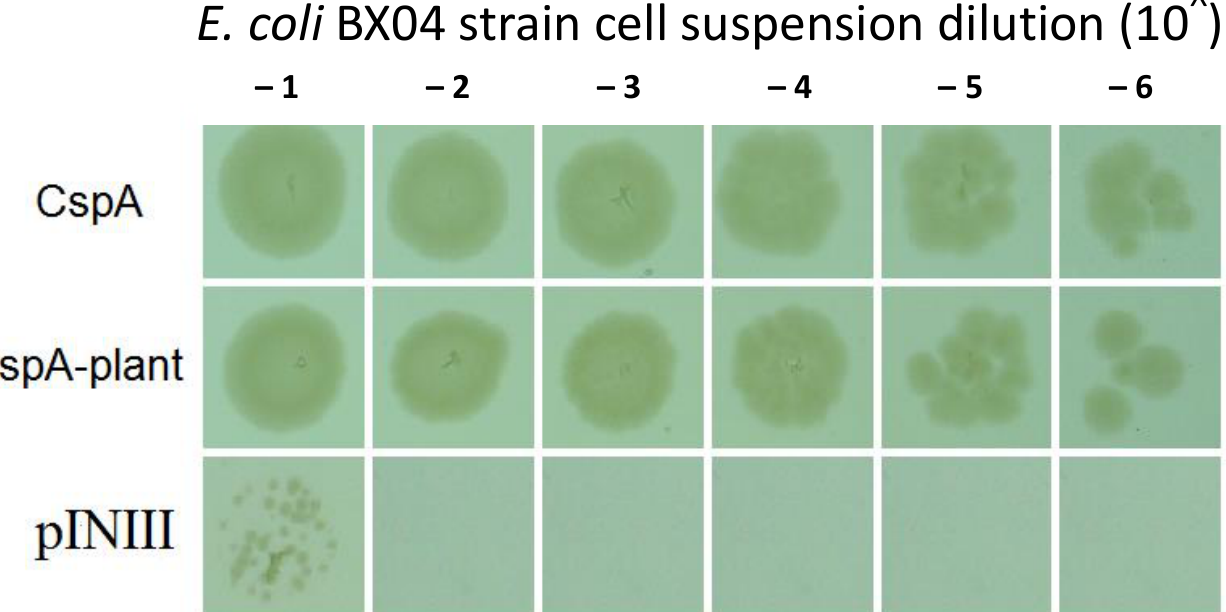
Figure 4. Plasmid expression of cspA-plant restores the growth capacity in the fourth mutant E. coli BX04 (Δ cspA , Δ cspB , Δ cspE , Δ cspG ) at a low temperature (+17 °С). Mutant bacteria were transformed with an empty vector (PINIII), a vector containing the cspA-plant gene, and the native cspA gene ( E. coli ).